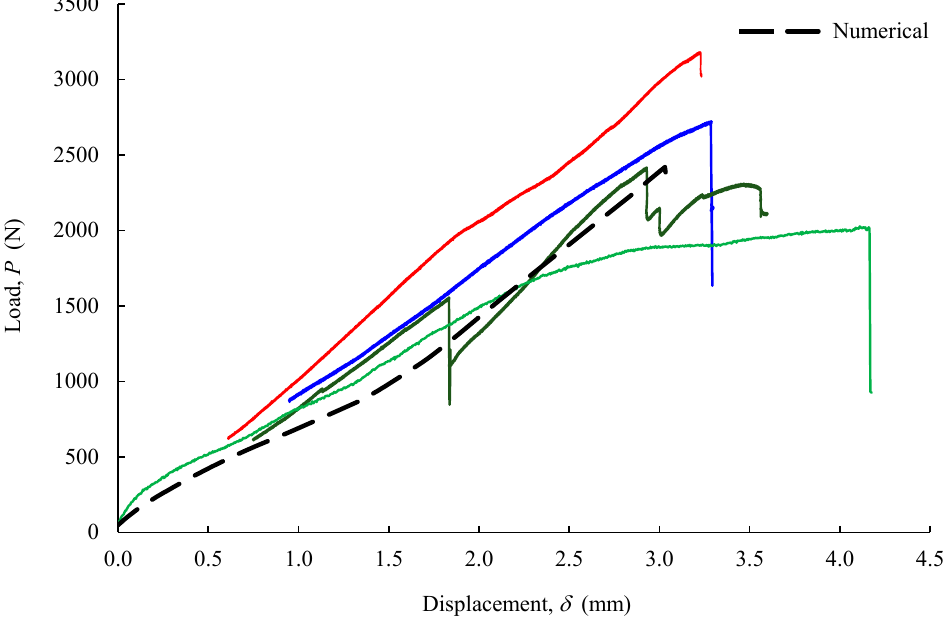
Figure 11. FPB tests (load–displacement) experimental curves.